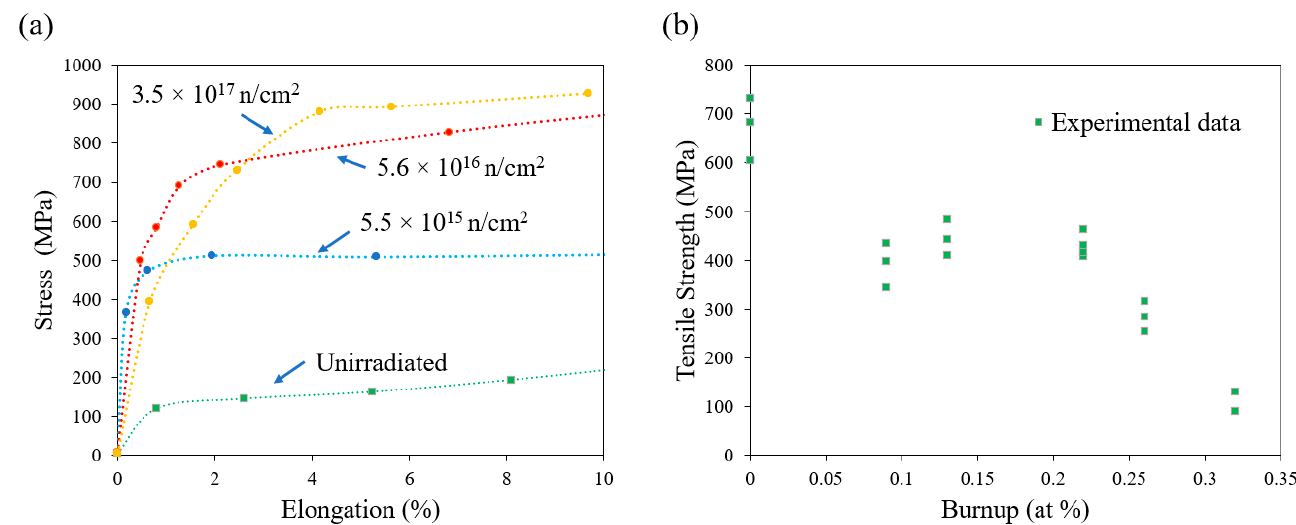
Figure 10. Irradiation effect on mechanical properties of ( a ) single crystal subjected to different irradiation fluences (Reprinted/adapted with permission from Ref. [52], 2022, Springer Nature) and ( b ) polycrystalline α -U (Reprinted/adapted with permission from Ref. [52], 2022, Springer Nature).